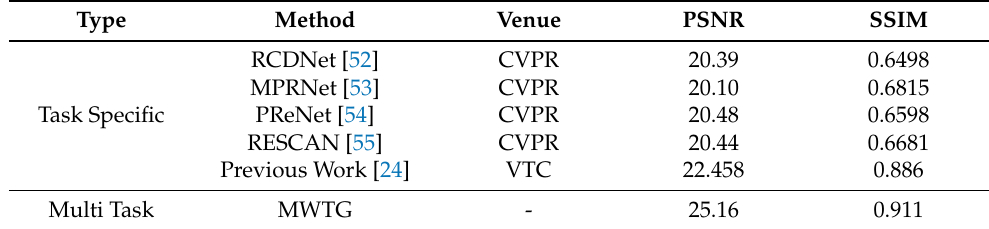
Table 2. Comparison of results with Rain Cityscapes.